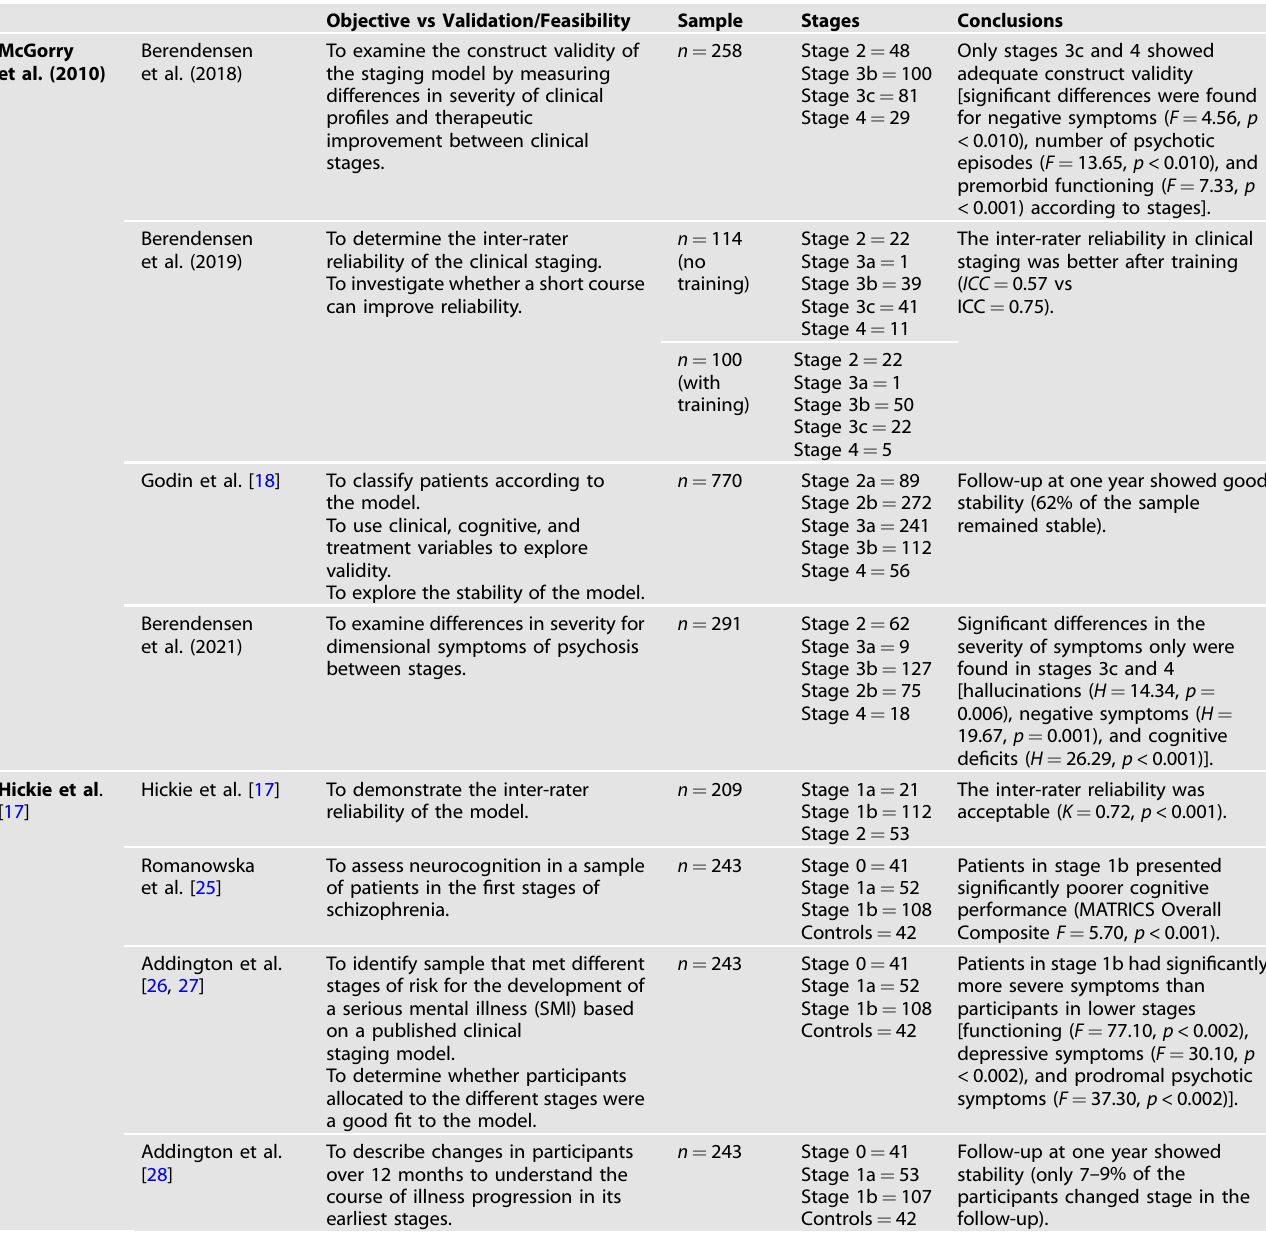
Table 2. Validation of the clinical staging